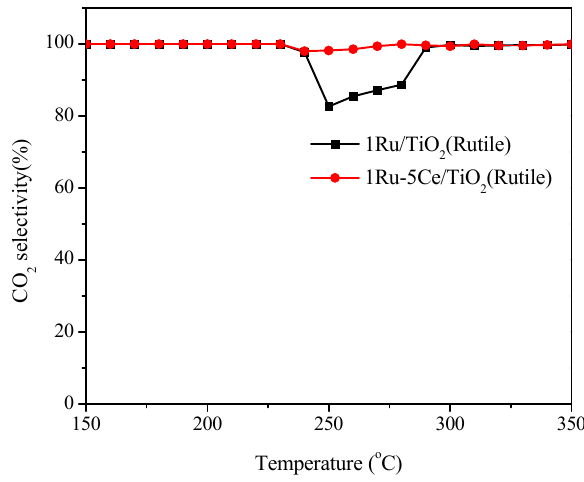
Figure 5. CO 2 selectivity of chlorobenzene oxidation over 1Ru/TiO 2 (Rutile) and 1Ru ‐ 5Ce/TiO 2 (Rutile) under the conditions of chlorobenzene concentration = 500 ppm, chlorobenzene/O 2 molar ratio = 1/400, and WHSV = 60,000 mL/(g h).